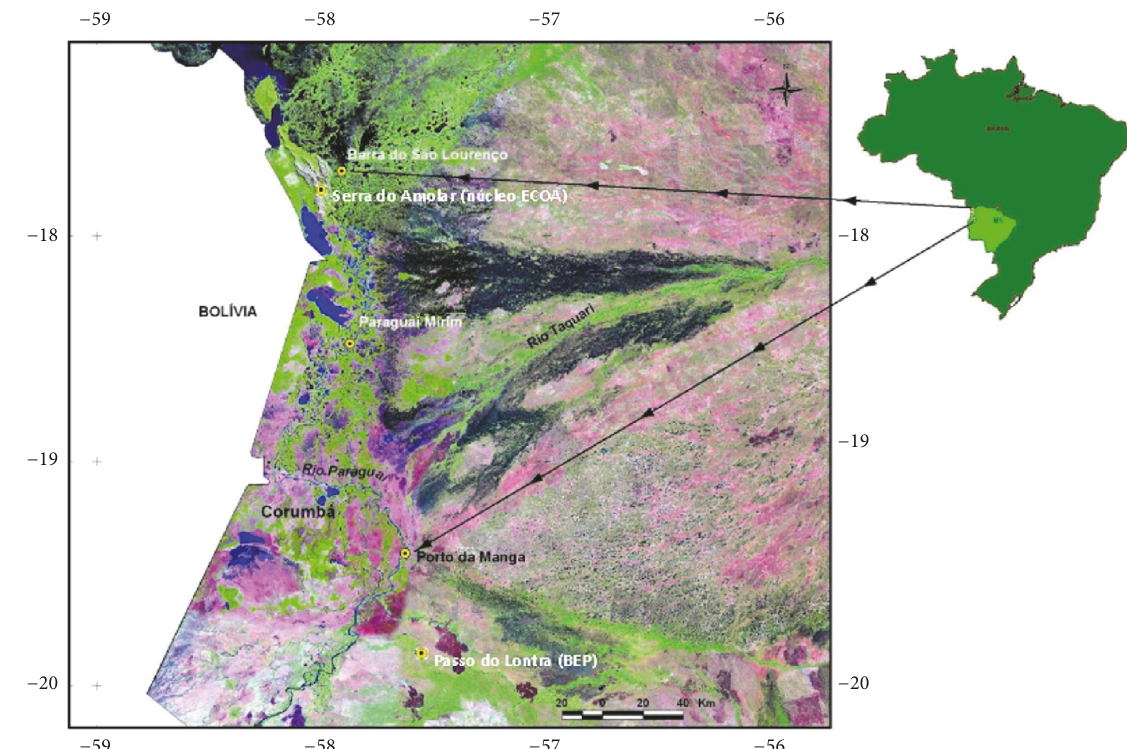
Figure 1: Location of the communities investigated. Source: ECOA,